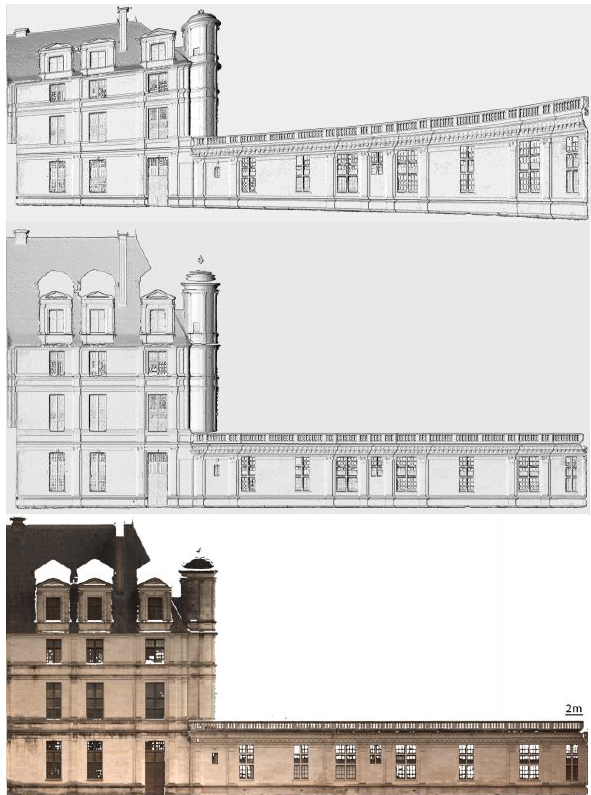
Figure 15: Façade FSO: shaded relief image in orthocylindric geometry, shaded relief image transformed in euclidian geometry and orthoimage.